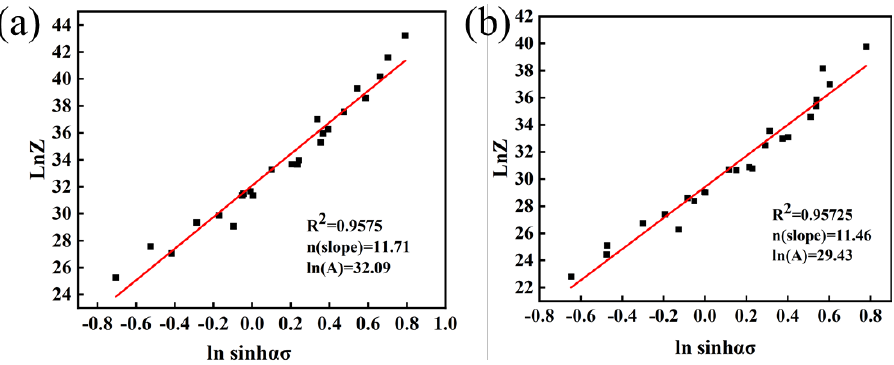
Figure 7. ln Z − ln [ sinh ( ασ )] relationship: ( a ) Mo–1.5wt%Al 2 O 3 , ( b ) Mo–1.5wt%ZrO 2 . For the Mo–1.5wt% ZrO 2 alloy: n 1 = 16.073, β = 0.0668, α = β / n 1 = 0.0042, n = 11.98, Q = 403.92 KJ/mol, S = 4.056 and lnA = 29.43, shown as in Figures 8 and 7b. Based on the above equations, the constitutive equations of the Mo–1.5wt%ZrO 2 alloy Equation (11) were constructed in the same